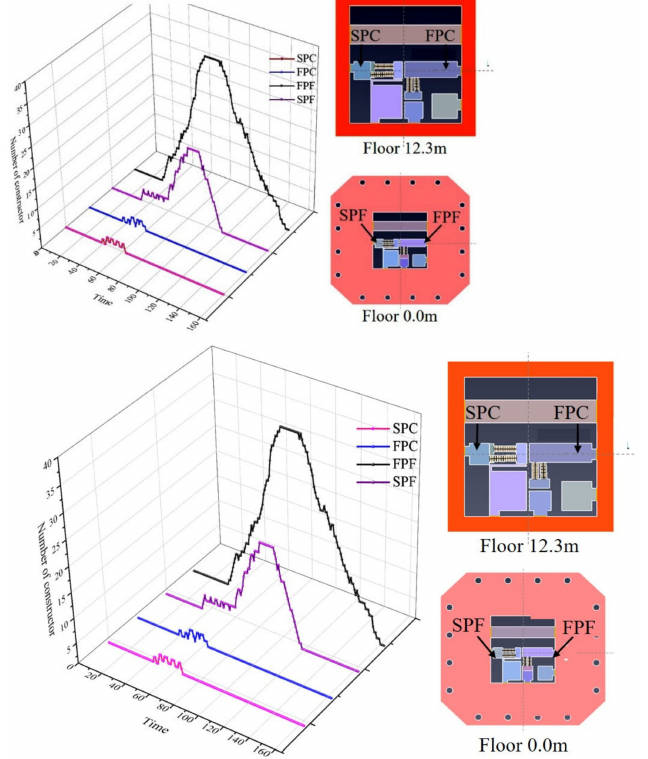
Figure 8. Number of the constructor on different platforms in evacuation. FPF (first platform of frame working face), SPF (second platform of frame working face), FPC (first platform of core tube working face), and SPC (second platform of core tube working